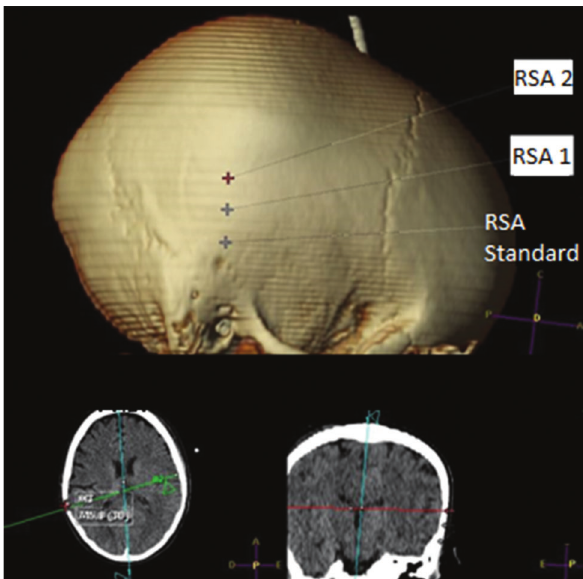
Figure 3 - Example of the sites for the standard RSA, RSA 1 and RSA 2 points.